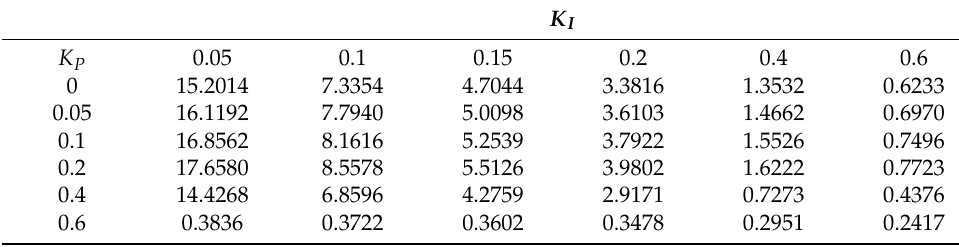
Table 4. Delay margin ( G m = 2, Φ m = 0 ◦ ).